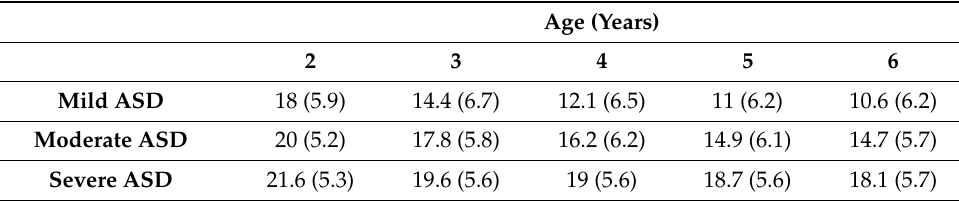
Table 3. Averaged Expressive Language (assessed by ATEC subscale 1) score for the mild, moderate, and severe ASD groups. A lower score indicates symptom improvement. The data are presented as the mean (SD).